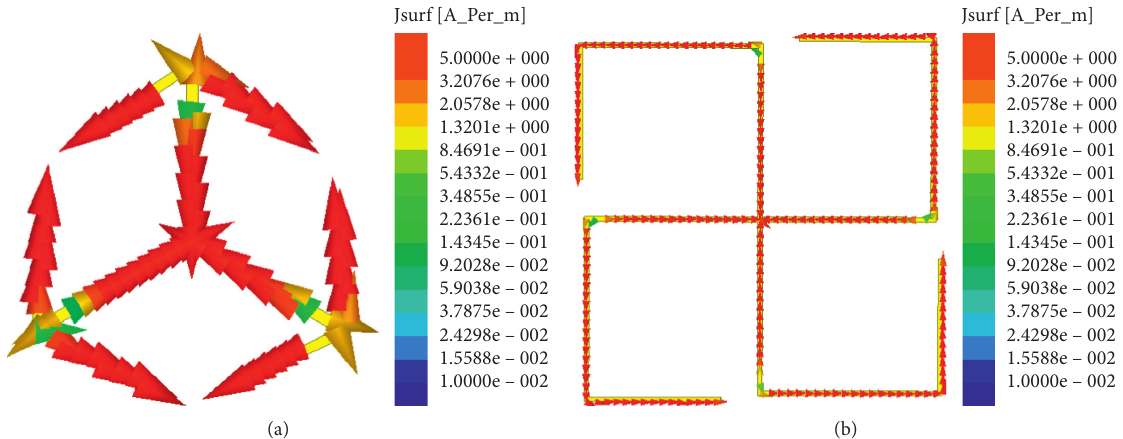
Figure 3: Current distribution. (a) Three-branch antenna. (b) Four-branch antenna.